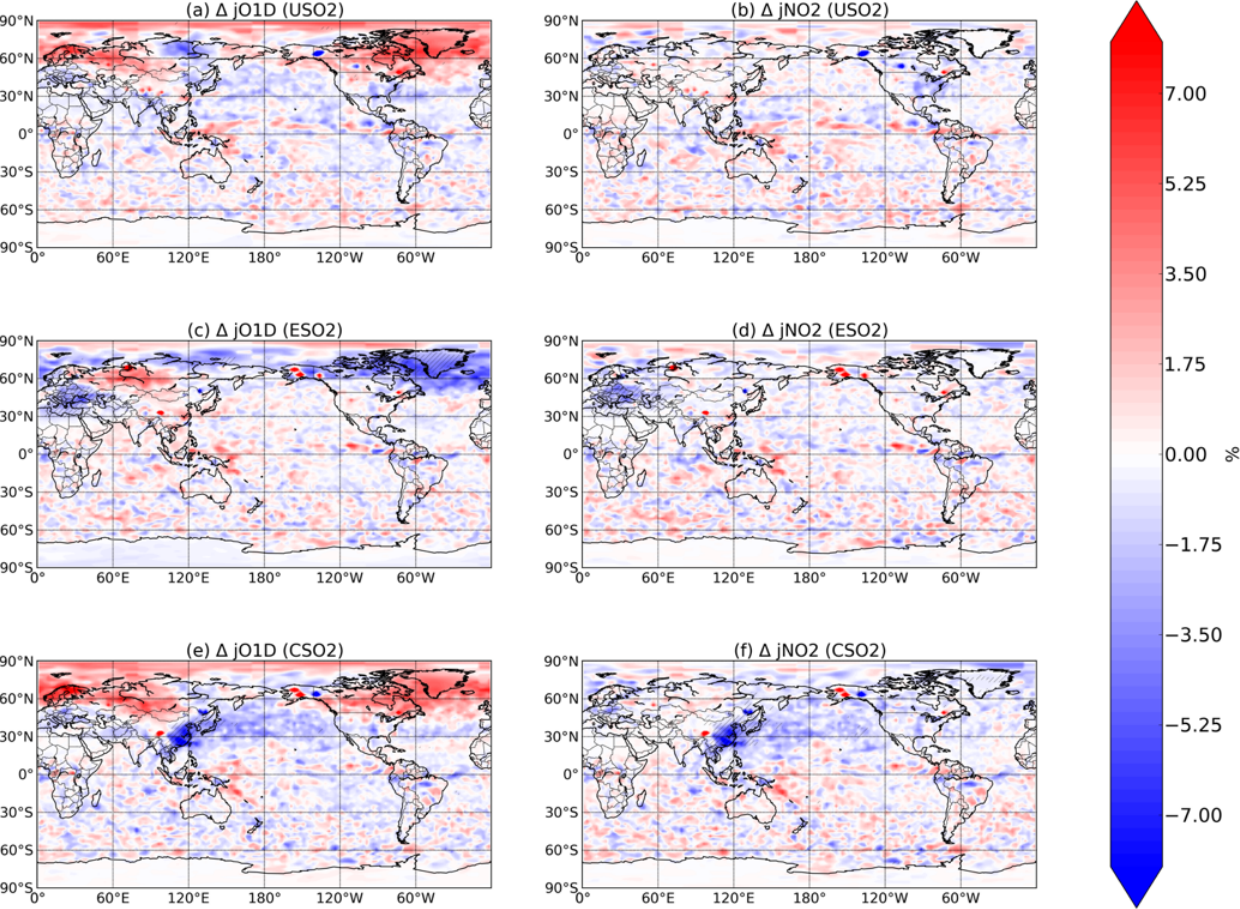
Figure 6. Boreal springtime (MAM) mean percent change in photolysis rates ( j simulation and a perturbation simulation in which anthropogenic SO 2 emissions are removed over a certain region: (a, b) US, (c ,d) Europe, and (e, f) China. Hatching denotes statistical significance according to a Student’s t test at the 95% confidence